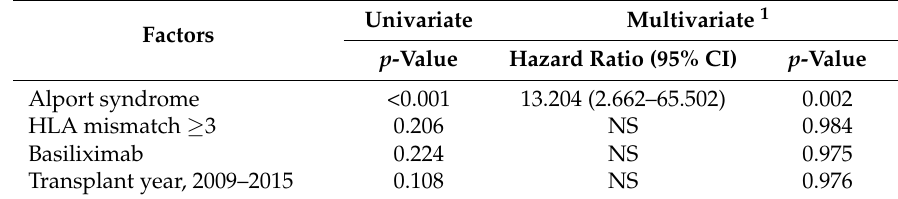
Table 2. Risk factors for BK virus